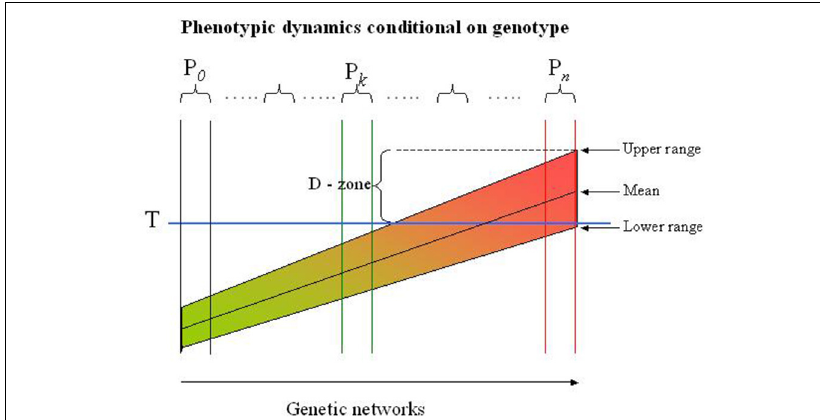
FIGURE 1 | Risk profile in genetic networks. The population in this example is partitioned into more homogeneous subpopulations (P i ) by the LCA-SEM procedure indicated by the sets of two vertical lines. Each subpopulation is genetically defined by an ensemble of networks with exactly the same topology but differs in genetic variations. The networks in each subpopulation arise by successive mutational incidences that are balanced (buffered) to generate a phenotype similar for all subjects in the subpopulation (see also the text). In reality the subpopulations represent different local maxima in a miltidimensional phenotypic landscape, but are for illustrative purposes collapsed to flat, two-dimensional presentation. The range of the phenotype (e.g., diastolic blood pressure) depends on extra-genetic factors, but can never exceed the range defined by the genotype. Thus, some subjects (genotypes) will never exceed the threshold (T), while others will experience the extreme phenotype (e.g., diastolic hypertension) regardless of extra-genetic factors. The D(anger) - zone indicates the subjects or subpopulations which may be classified in this examples as diastolic hypertensive. However, this may depend on the circumstances under which the blood pressure is measured, i.e., subjects may be classified as normotensive although they have a massive propensity to develop hypertension. Dichotomizing the trait in a population is thus a dubious affaire and compromise most association studies to the point that information of the genetics of, in this case diastolic blood pressure, is entirely